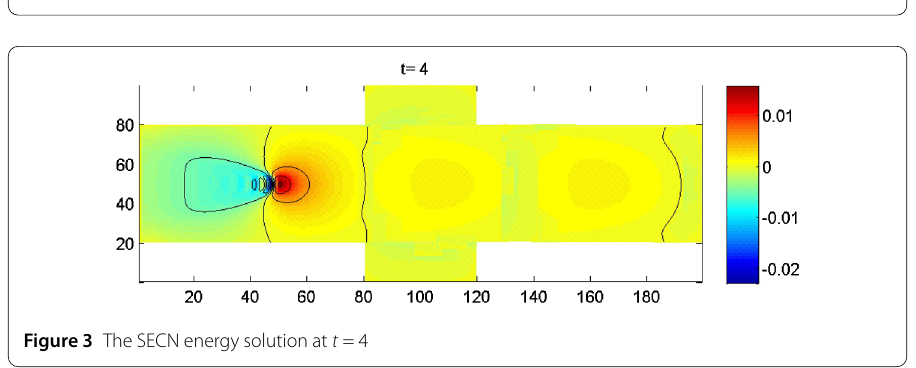
Figure 2 The SECN velocity solution at t = 4